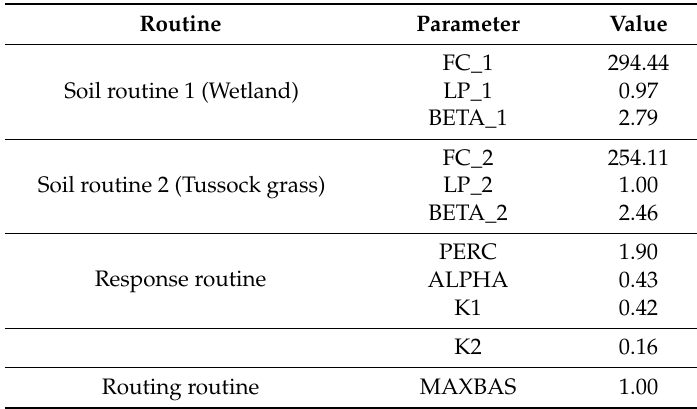
the calibration period and the start of the validation period.